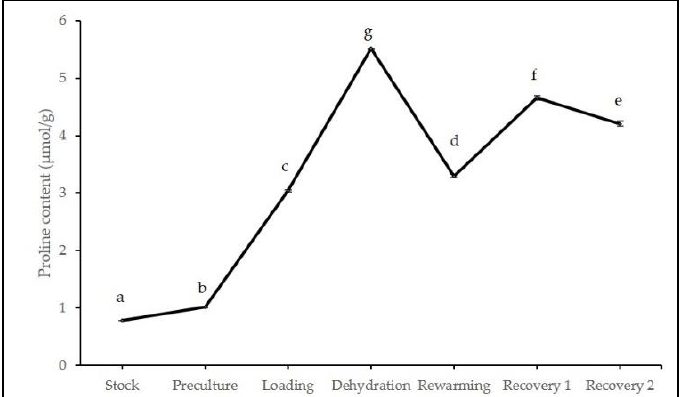
Figure 6. Proline content of cryopreserved axillary buds at different stages in cryopreservation. Error bars represent standard errors. Means with different letters are significantly different based on Duncan Multiple Range Test (DMRT) at p ≤ 0.05.